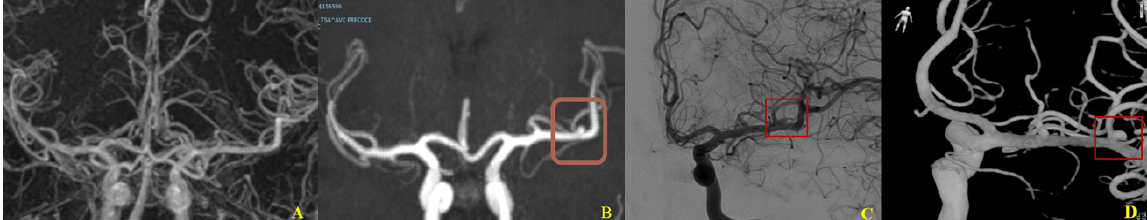
Figure 2. Illustrative case of a de novo aneurysm development. A 48-year-old lady with clinical history of seizures since childhood was admitted with a transient episode of right-sided paresthesia and hemiplegia. MRI/MR-Angiography (TOF sequence) performed in 2008 was normal without vascular anomalies ( A ). Follow-up MR-Angiography (TOF sequence) performed in 2016 showed a small de novo aneurysm of the left middle cerebral artery bifurcation (colored box) measuring 2.3 mm ( B ). Cerebral DSA was performed a month later to analyze more precisely the aneurysm (colored box) ( C , D ).